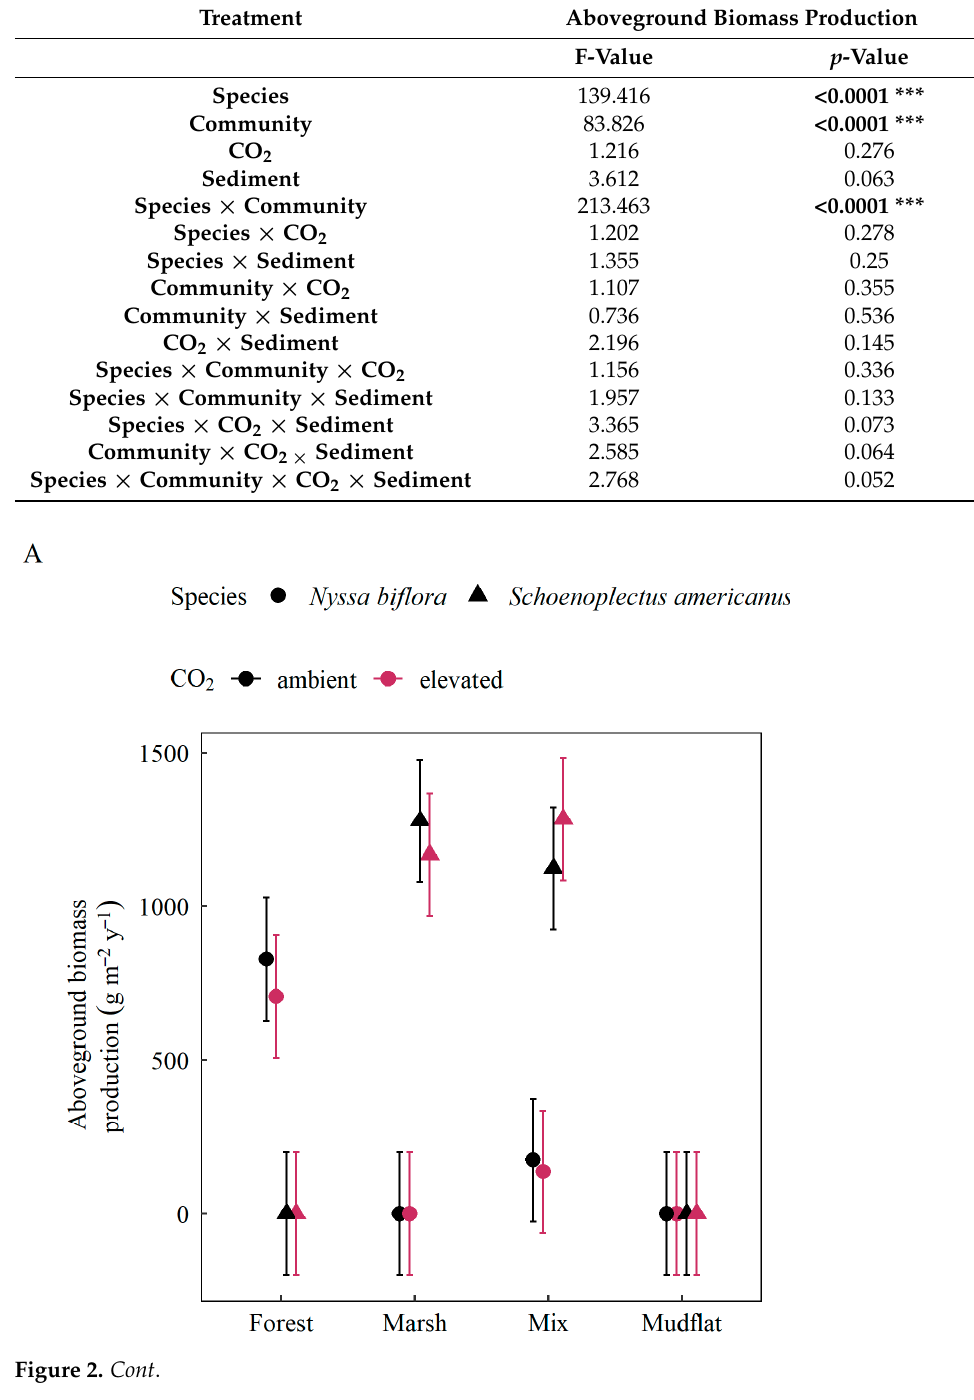
Figure 2. Annual aboveground biomass production of Nyssa biflora (circles) and Schoenoplectus amer- icanus (triangles) by community and CO 2 (ambient: black, elevated: magenta). ( A ) No sediment dep- osition. ( B ) Sediment deposition. Response variable values are model-based estimated marginal